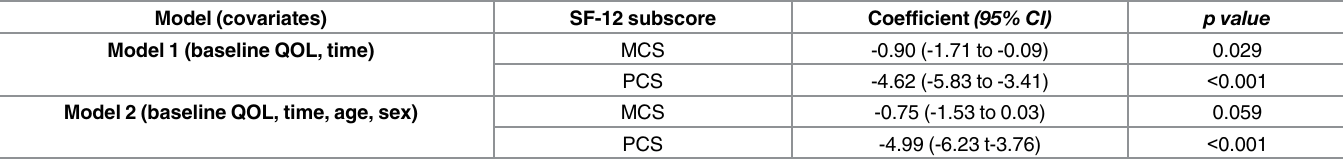
Table 6. Quality of life (QOL) models comparing mean scores across time on MCS and PCS subscales of SF-12, according to baseline HADS (cut- off 12). Model